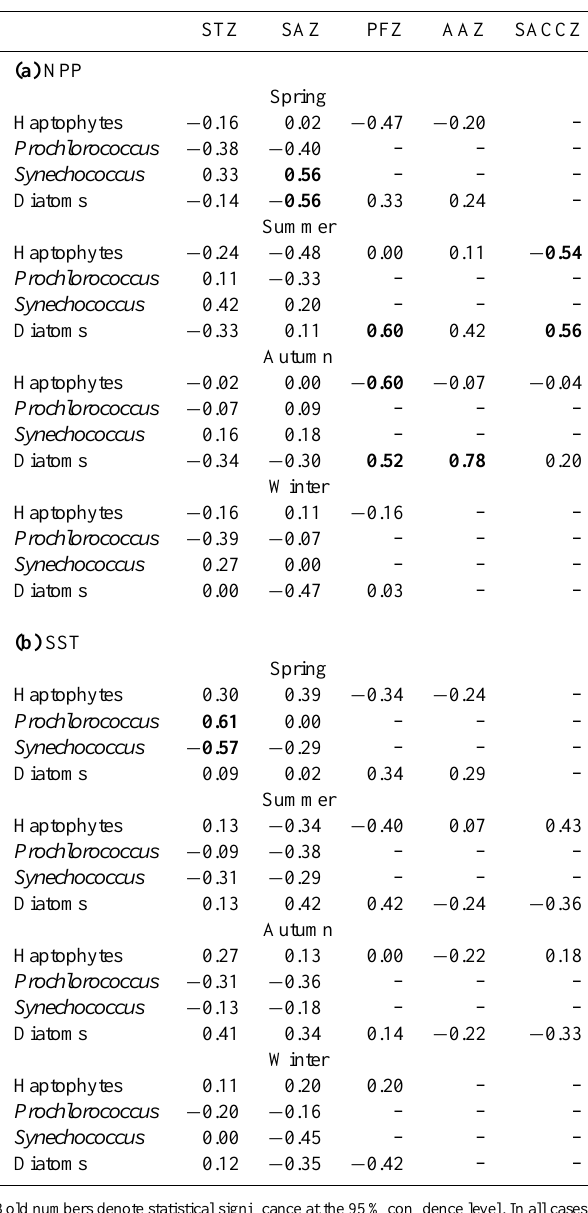
Table 5. Kendall’s rank correlations between the dominant ratios for each phytoplankton group determined by PHYSAT and (a) NPP or (b) SST in the five frontal zones.